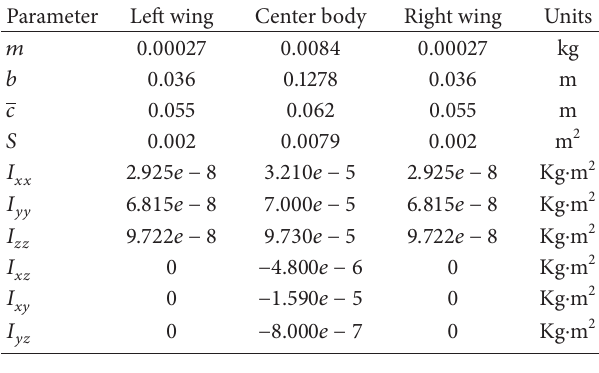
Table 1: Physical properties of the articulated MAV. Parameter